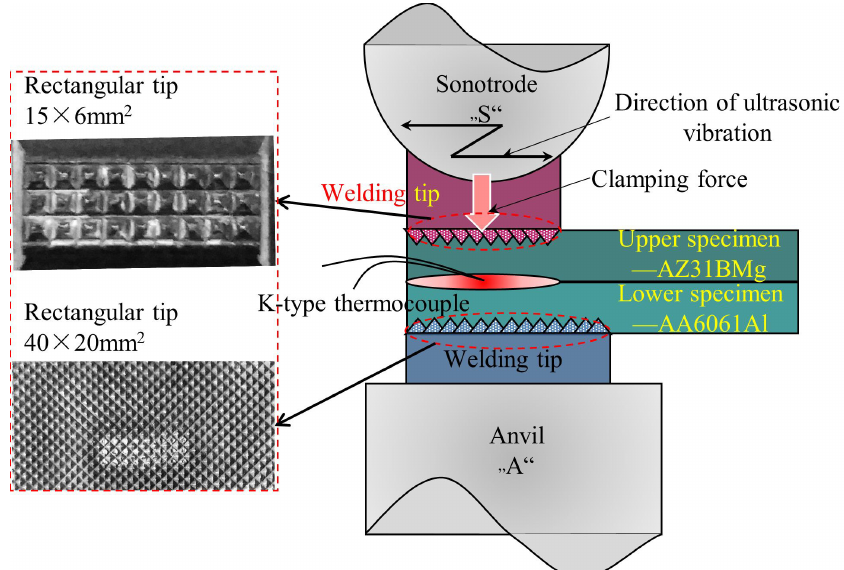
Figure 1. A sketch of the ultrasonic welding equipment and sonotrode